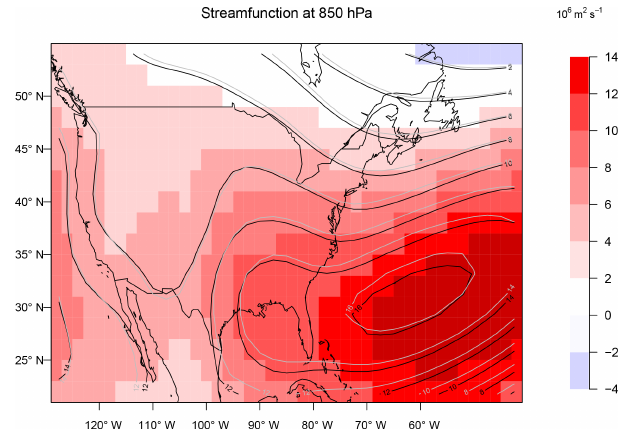
Figure 4. JJA 20-year average streamfunction (10 6 m 2 s − 1 ) at 850hPa for ERA-Interim reanalysis (shade), GCM2000 simulation (black contour), and GCM2100 simulation (gray